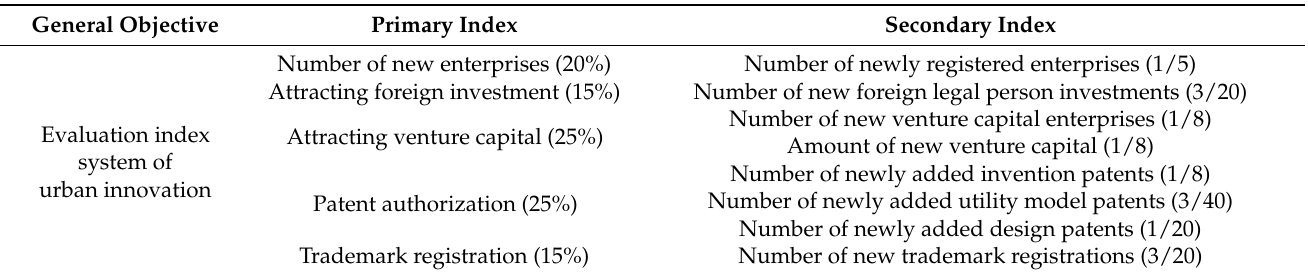
Table 1. Evaluation index system of urban innovation.